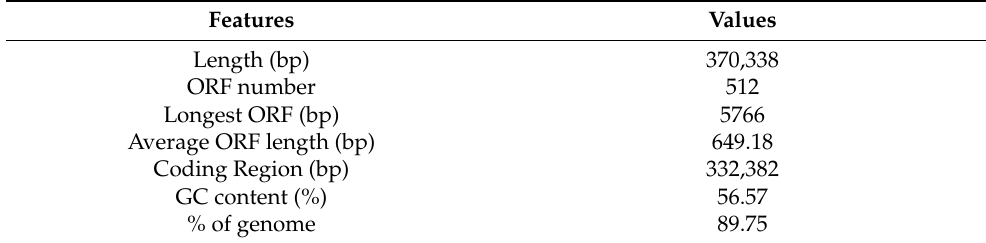
Table 1. The general features of plasmid pRBL16.